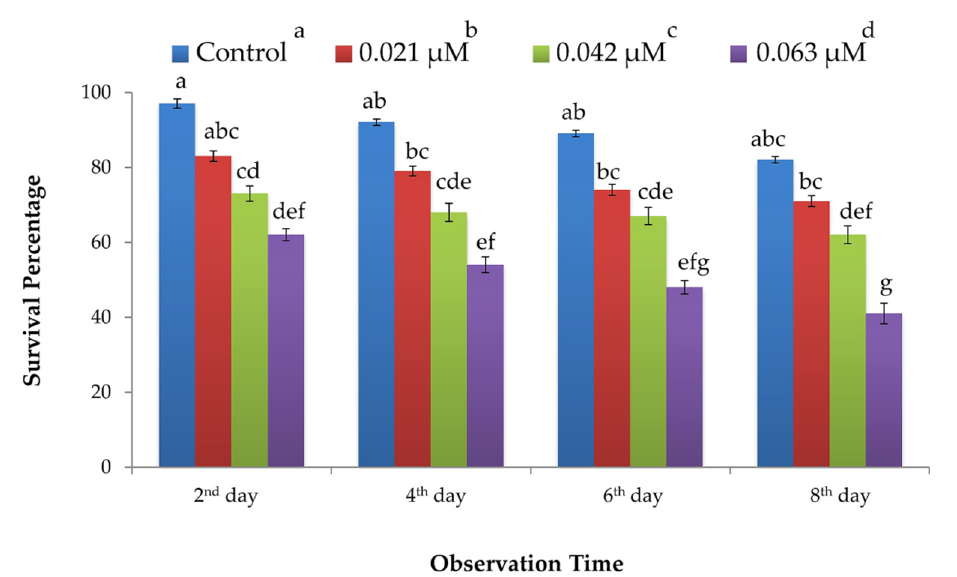
Figure 2. Survival percentage ( ± SEM; n = 10 for each treatment) of whitefly ( B. tabaci ) recorded for different concentrations of partially purified protein derived from B. bassiana (ARSEF 2860). Different letters indicate significant difference among treatments (univariate ANOVA; SNK test at α = 0.05). (cf. Table 1).